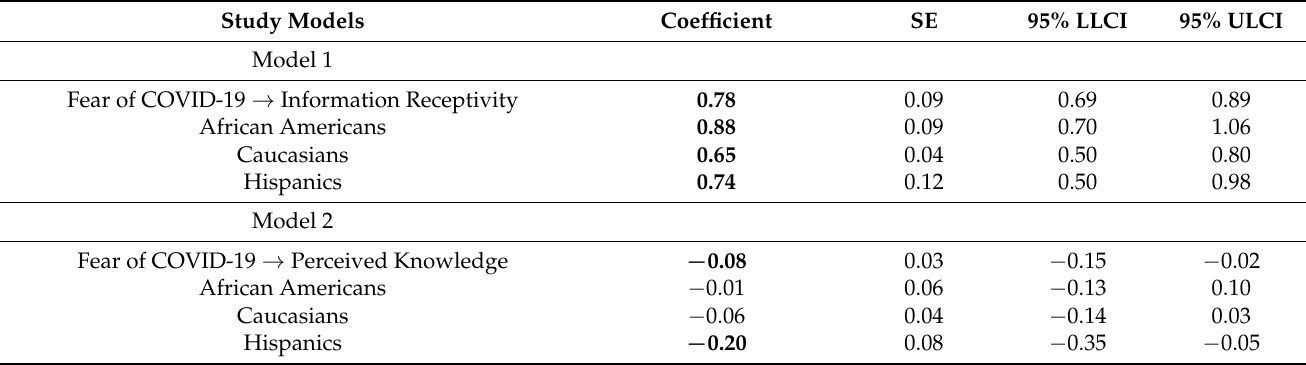
Table 4. Sequential Mediation Results for All Models Including All Direct and Indirect Effects. Study